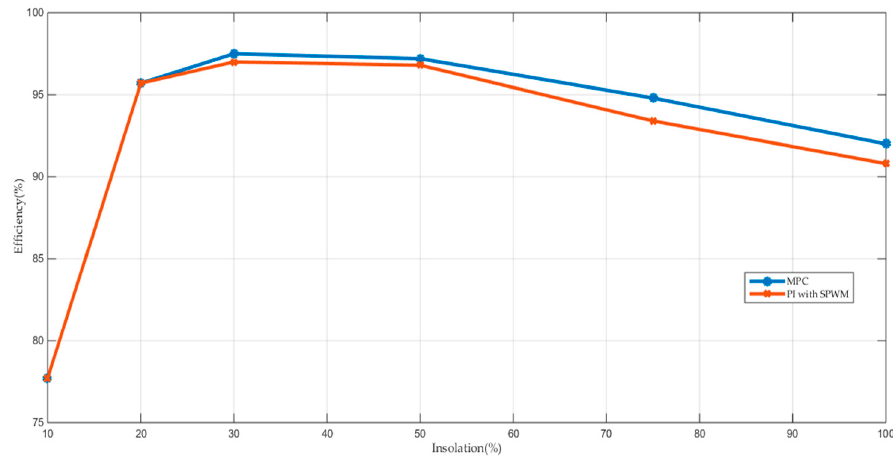
Figure 13. Variation of the system efficiency with the insolation level for the MPC controller and PI current controller with SPW modulation.